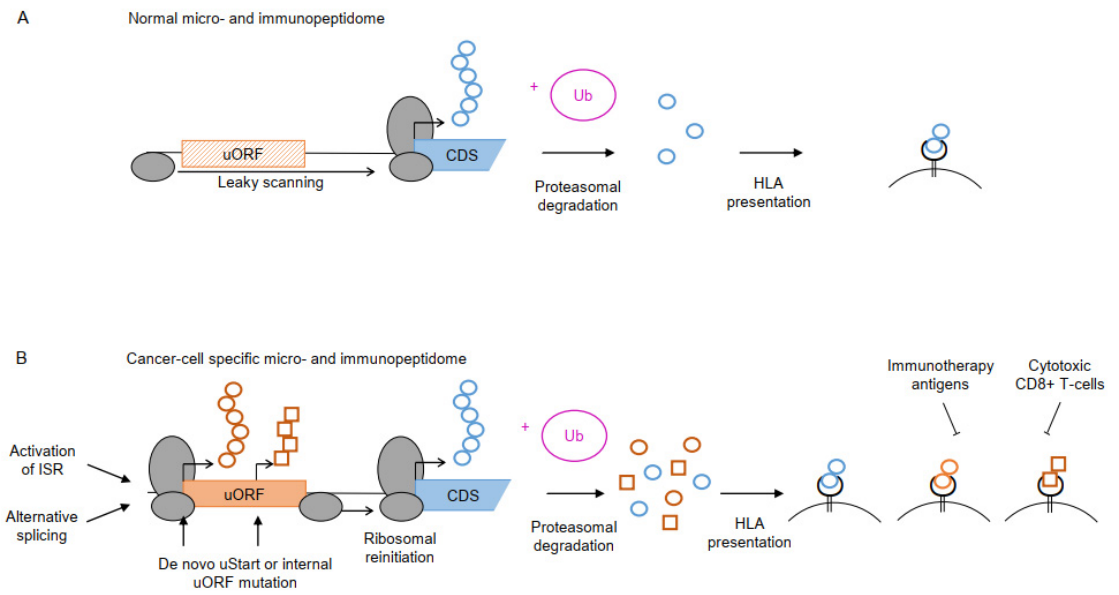
Figure 3. Non-canonical uPeptide-derived neoantigens. ( A ) A large fraction of cellular proteins undergo proteasomal degradation upon ubiquitylation (+Ub) and will partly be presented on the cell surface as HLA ligands. ( B ) Upon tumorigenesis, diverse mechanisms including the activation of the ISR or alternative splicing may enable translation of previously skipped or non-existing uORFs (orange box). Somatic mutations in de novo uORF start (uStart) sites or internal uORF sequence may result in novel uPeptides or changes in uPeptide sequences, altering the micropeptidome compared to healthy cells. Proteasomal degradation of the novel uPeptides generates cancer cell-specific HLA complexes, which may be targetable by immunotherapeutic antigens or cytotoxic T-cells, indicated by inhibitory arrows.